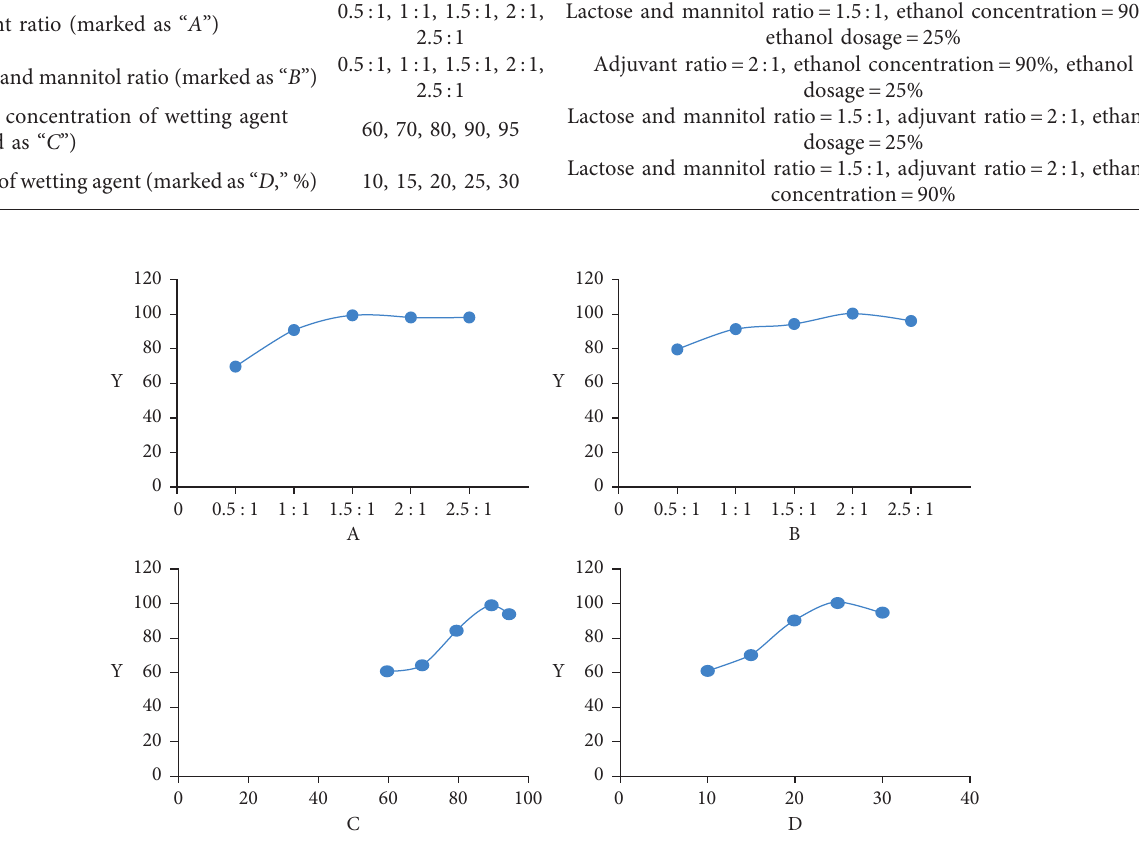
Figure 1: The influence of each single factor on the comprehensive score. Table 2: Analysis of factors and level coding of response surface